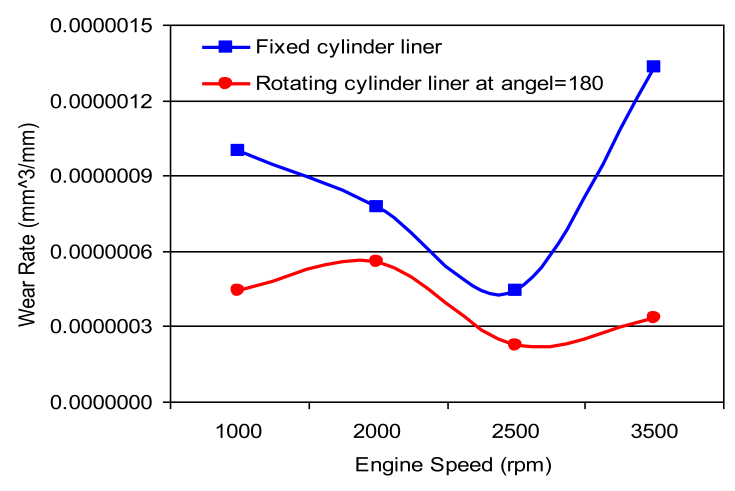
Wear rate of cylinder liner (rotating cylinder liner positioned at 180o angle.